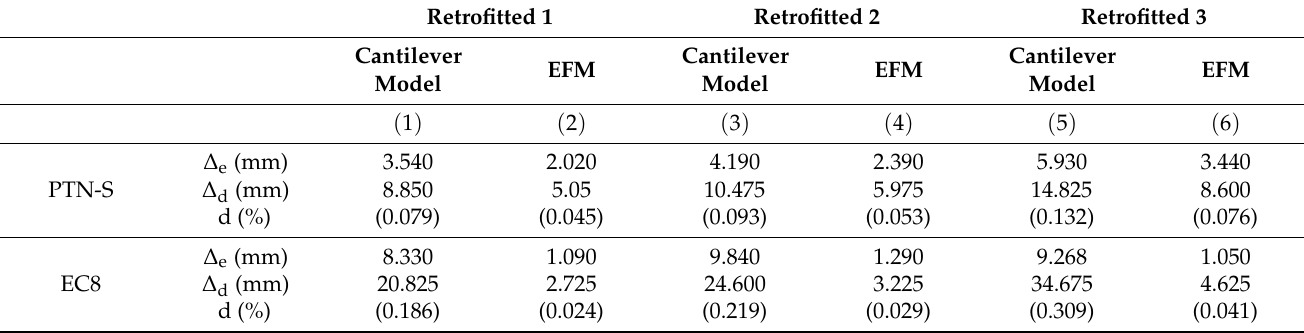
Table 11. Lateral displacements and total drift ratio for the retrofitted structure in N–S